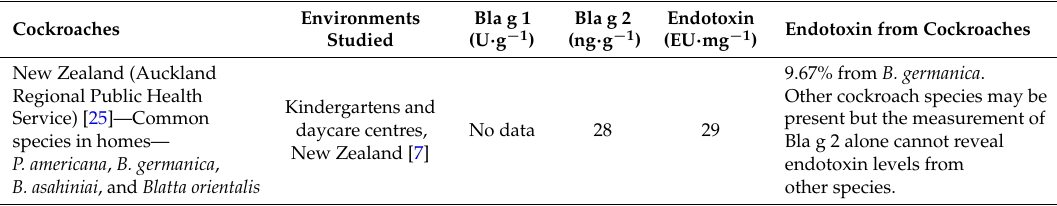
Table 4. Contribution of cockroach endotoxins to environmental